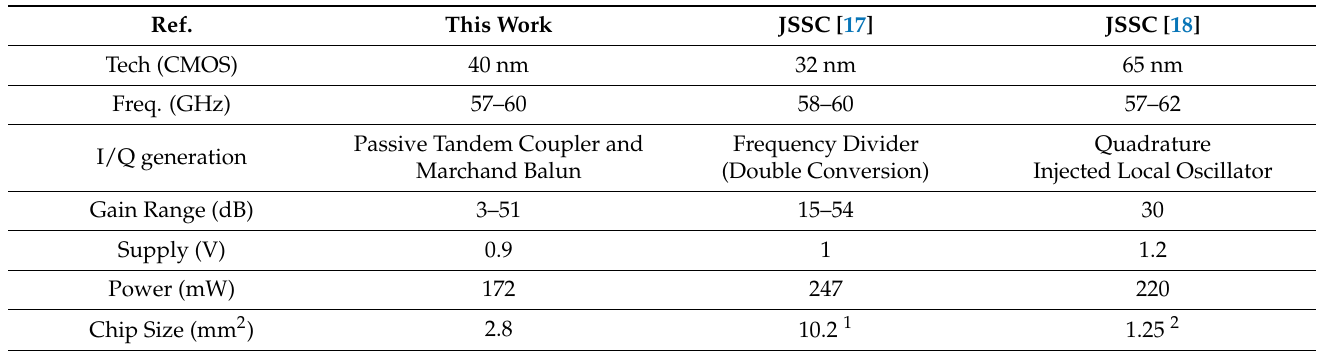
Table 1. Performance summary and comparison of 60 GHz I/Q